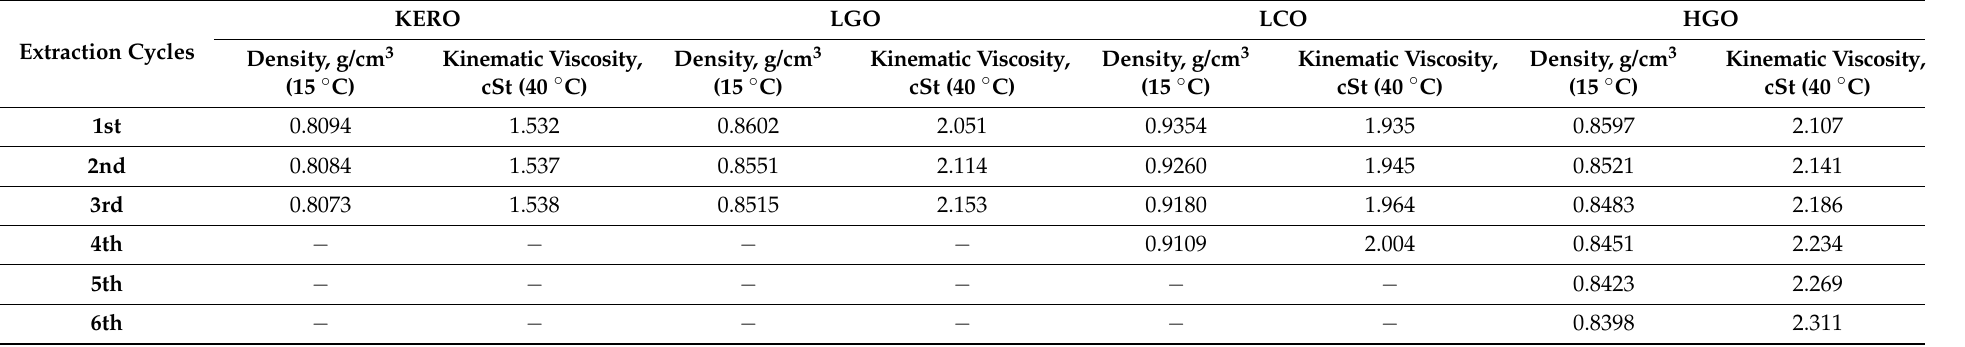
Table 7. Density and kinematic viscosity of the surrogate raffinates during the multiple-stage extractions with fresh